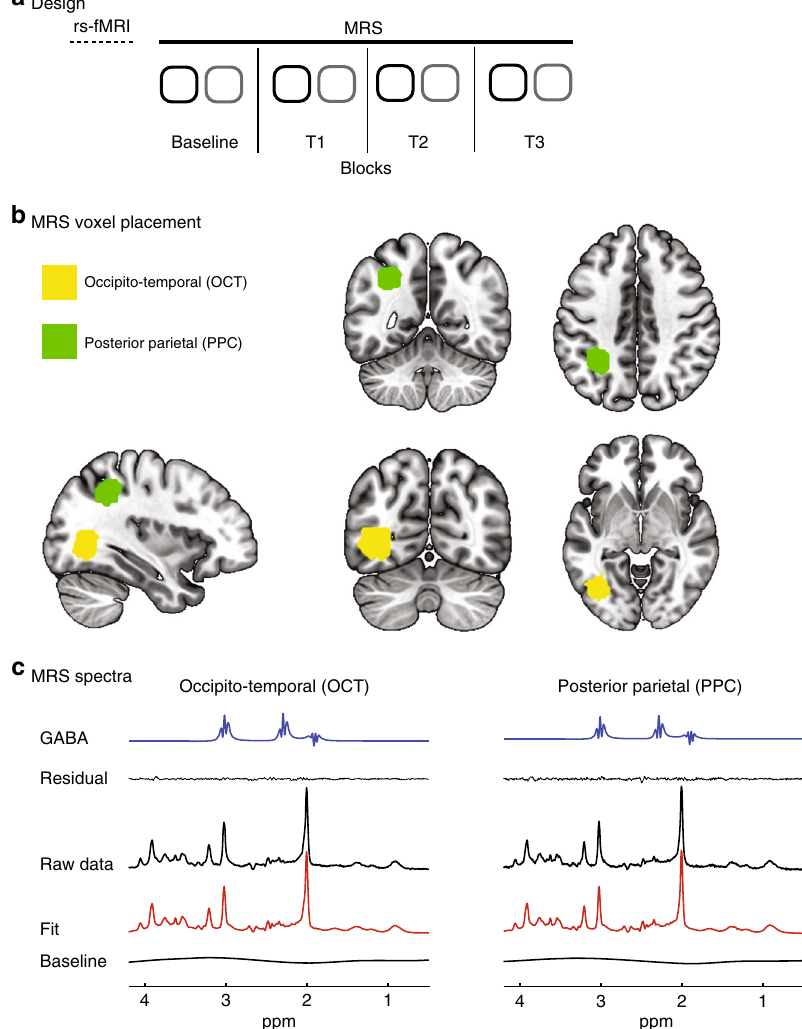
Fig. 2 Task design, and MR spectroscopy (MRS) voxels. a Design: Each participant took part in a single session during which we acquired resting-state functional MRI (rs-fMRI) and MRS data. We collected MRS GABA during one block before (Baseline) and three blocks during training (T1, T2, T3). Each block comprised two MRS acquisitions: one from occipito-temporal (OCT voxel — black squares) and one from posterior parietal (PPC voxel — gray squares) cortex. The order of the voxels within each block was counterbalanced across participants. During each block, participants were presented with stimuli for 400 trials (200 trials per MRS voxel acquisition). b MRS voxel placement: We positioned the MRS voxels using anatomical landmarks (superior temporal gyrus and middle occipital gyrus for OCT and intraparietal sulcus for PPC) on the acquired T1 scan to ensure that voxel placement was consistent across participants. The mean GM tissue fraction was 44 ± 8% for OCT and 46 ± 7% for PPC and GM tissue content did not differ signi fi cantly between the